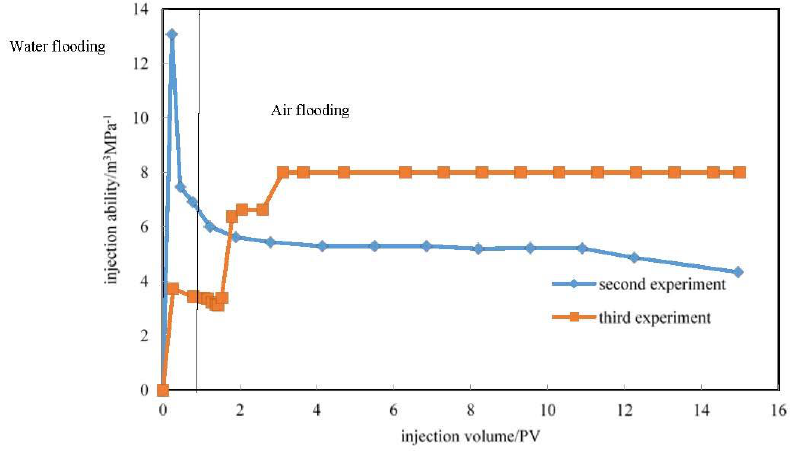
Figure 14. The second and the third group experiments of injection ability and injection multiples contrast analysis.